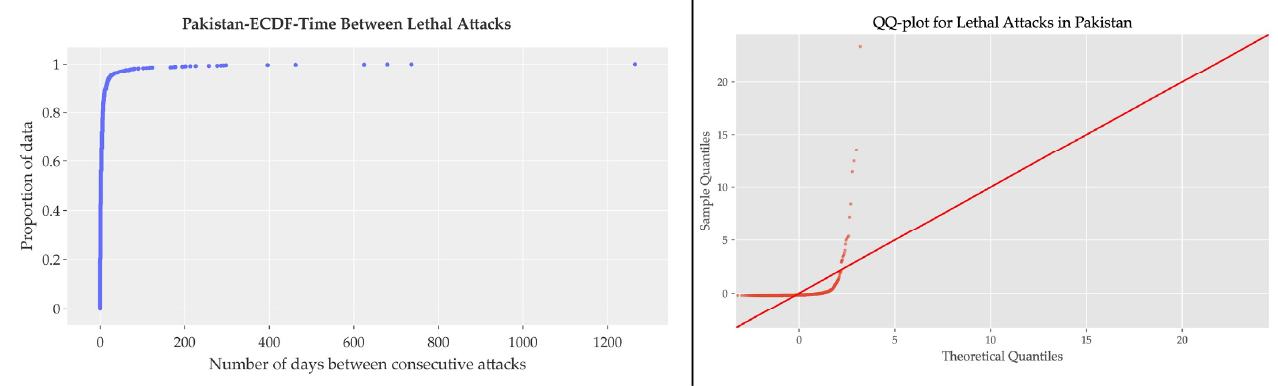
Figure 8. The time between consecutive lethal a tt acks and the corresponding QQ plot for Pakistan.